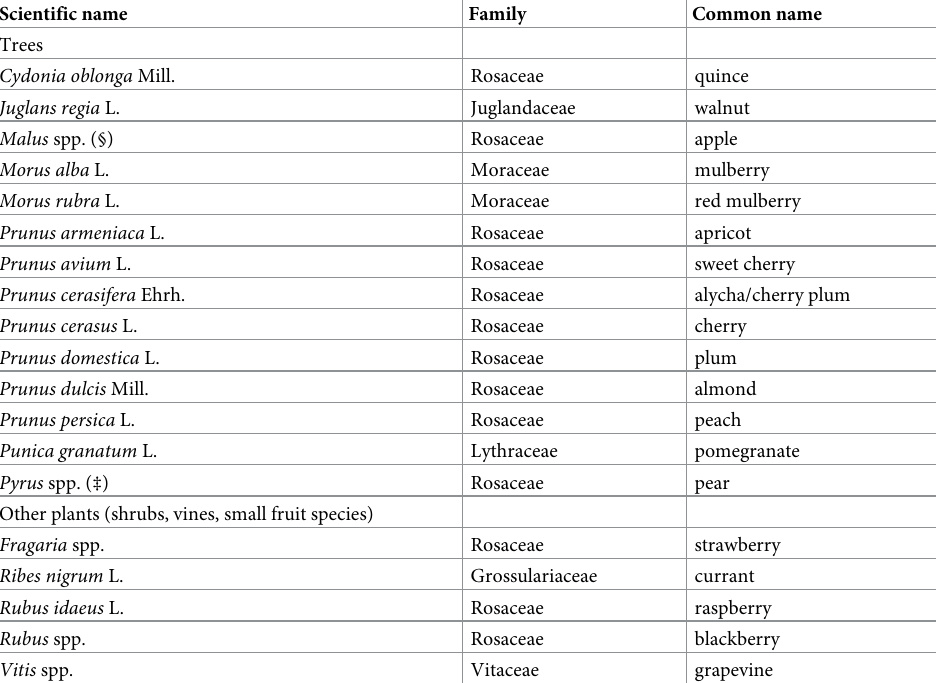
Table 2. List of species cultivated in home gardens across the study sites in all countries. Scientific name Family Common name Trees Cydonia oblonga Mill. Rosaceae quince Juglans regia L. Juglandaceae walnut Malus spp. (§) Rosaceae apple Morus alba L. Moraceae mulberry Morus rubra L. Moraceae red mulberry Prunus armeniaca L. Rosaceae Prunus avium L. Rosaceae sweet cherry Prunus cerasifera Ehrh. alycha/cherry plum Prunus cerasus L. Rosaceae cherry Prunus domestica L. Rosaceae plum Prunus dulcis Mill. Rosaceae almond Prunus persica L. Rosaceae peach Punica granatum L. Lythraceae pomegranate Pyrus spp. (‡) Rosaceae pear Other plants (shrubs, vines, small fruit species) Fragaria spp. Rosaceae strawberry Ribes nigrum L. Grossulariaceae currant Rubus idaeus L. Rosaceae raspberry Rubus spp.